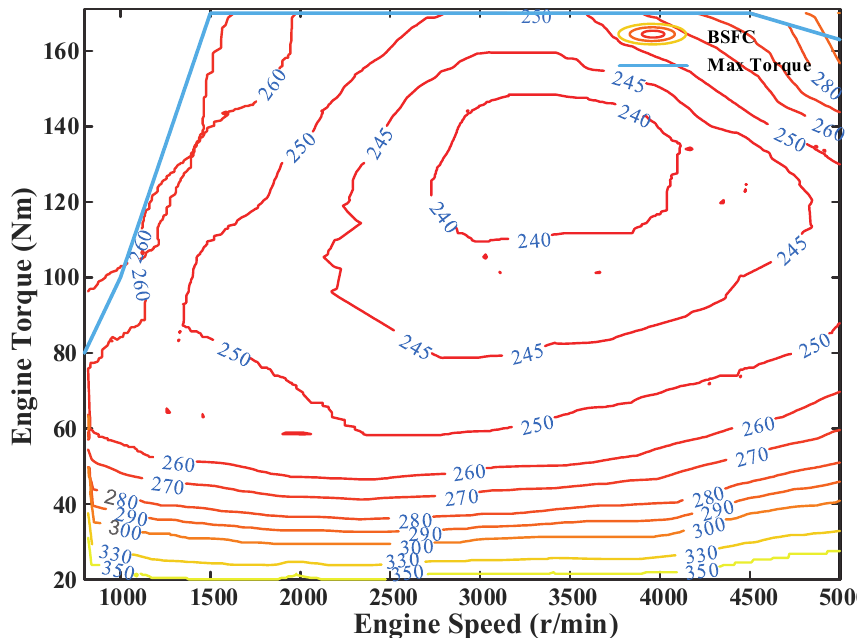
Figure 3. Universal characteristics of the engine.